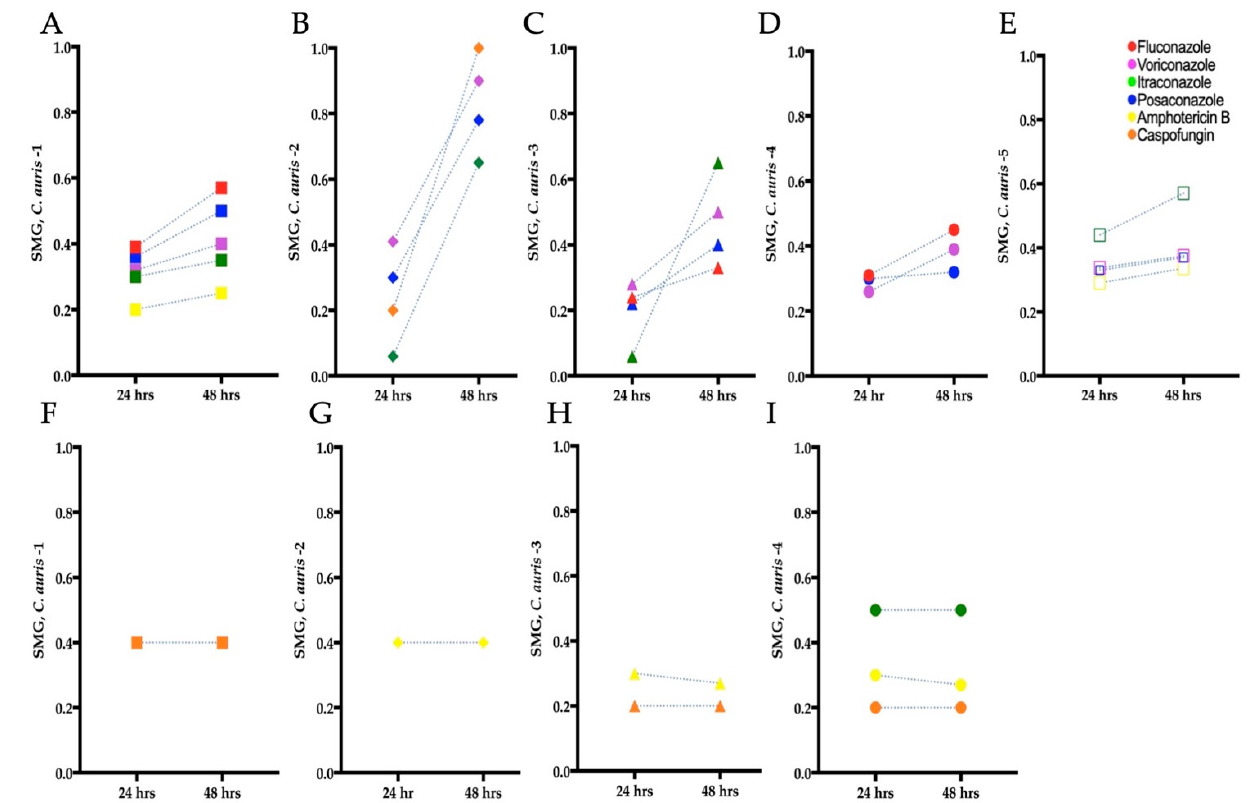
Figure 3. Tolerance from supra-MIC growth (SMG) for clinical C. auris isolates grown in antifungal microwell plates. ( A – E ) Mean SMG of tolerant isolates after 24 and 48 h. ( F – I ) Mean SMG of non- tolerant isolates after 24 and 48 h. C. auris 5 was resistant to fluconazole and caspofungin hence tolerance/non-tolerance could not be determined for these isolate–antifungal combinations.